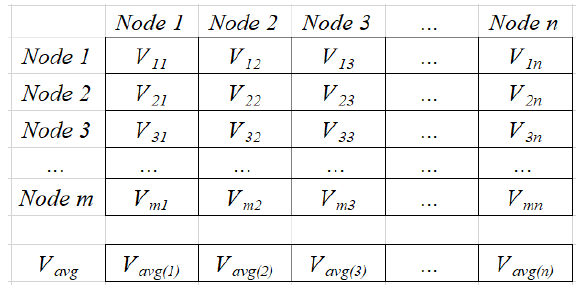
Figure 2. Cross mean table.